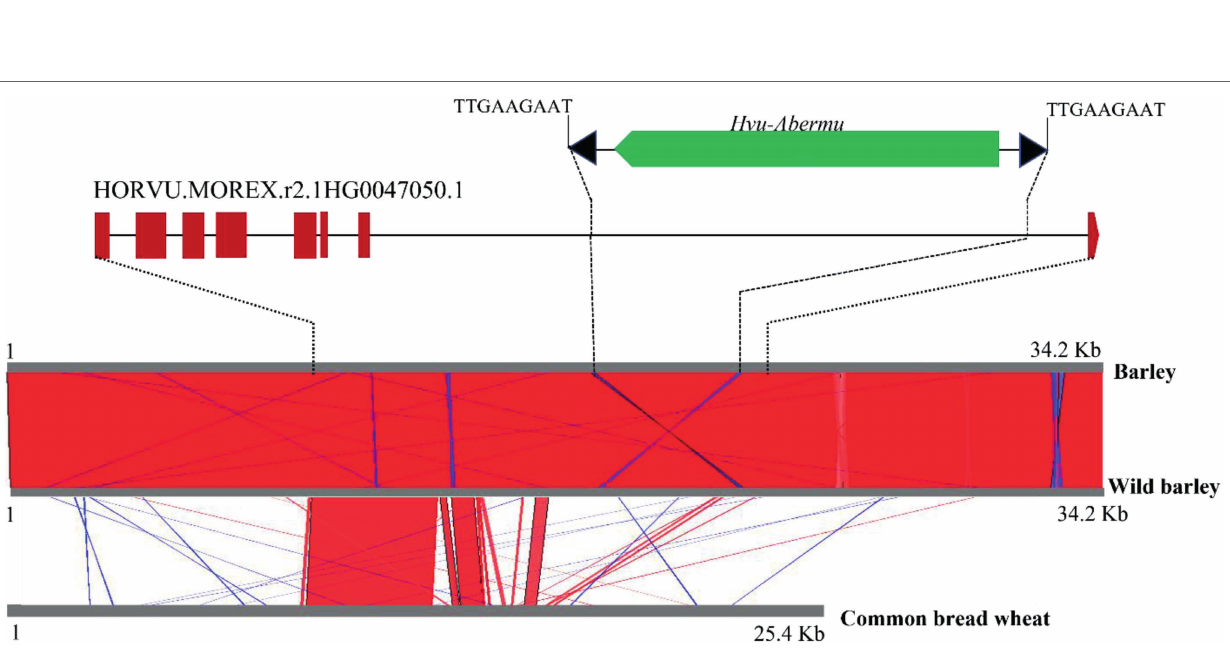
FIGURE 6 | Sequence alignments of the orthologous genes and 20-Kb flanking regions in cultivated and wild barley and bread wheat. Top shows the structure of the barley HORVU.MOREX.r2.1HG0047050.1 gene and the inserted Hvu_Abermu element. The brown rectangles/pentagon represent the exons of the barley gene, and the black solid lines mean introns of the gene. Bottom is the alignments of the orthologous genes and flanking regions. Red means shared sequences showing same orientations and blue means shared regions with